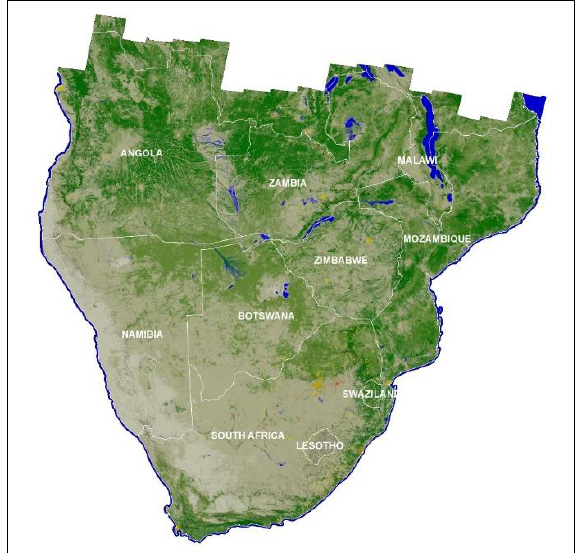
Figure 1. GTI’s Southern African Land-cover